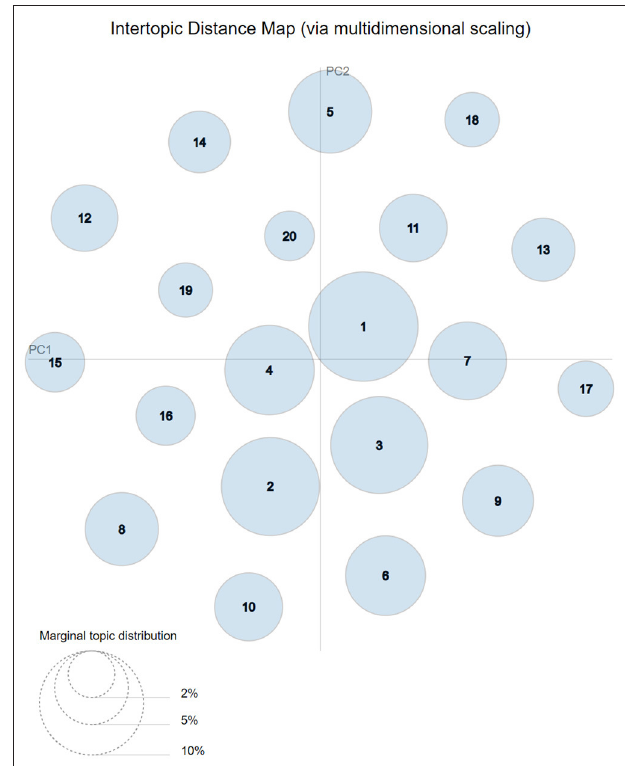
Figure 3 | The intertopic distance map.